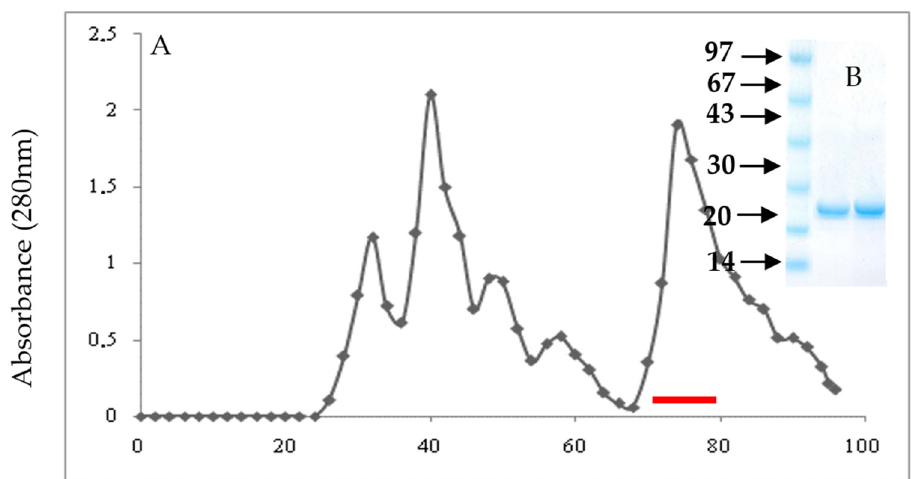
Figure 2. Purification of α AI.Mol: ( A ) gel filtration chromatography on Sephadex G-50. Column of G-50 (2.5× 100 cm) equilibrated with 0.1 Μ Tris-HCL buffer, pH 8, containing 0.2 Μ NaCl. The column was eluted with the same buffer at a flow rate of 30 mL/h, and 4.55 mL fractions were collected. Red line: active fractions. ( B ) SDS-PAGE analysis. Twenty micrograms of the active fractions containing the amylase inhibitor activity.